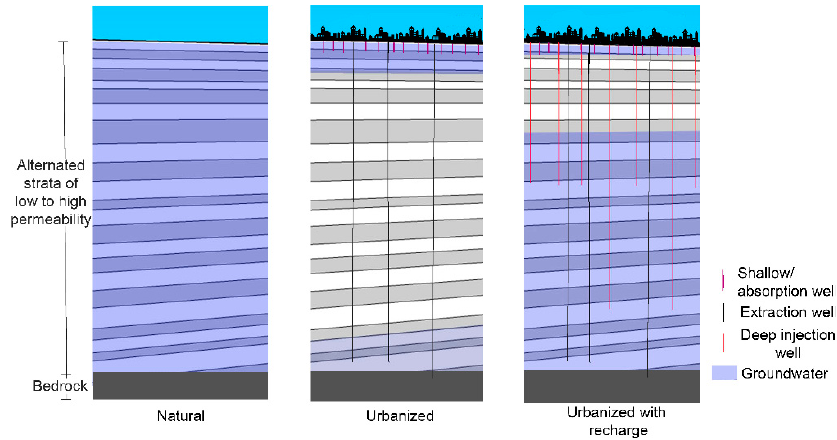
Figure 6. Conceptual scheme.